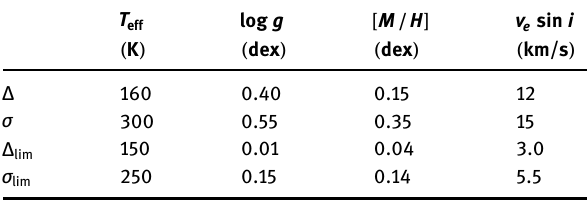
The last two rows deal with a limited cataloged sample, the one used to plot Figures 4 –